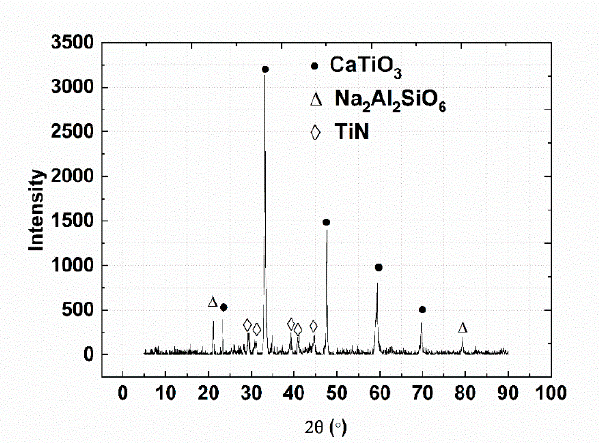
Figure 13. XRD analysis of crust slag from mold. Table 5. Main compositions (wt. %) and properties of slags following steel-slag reaction.